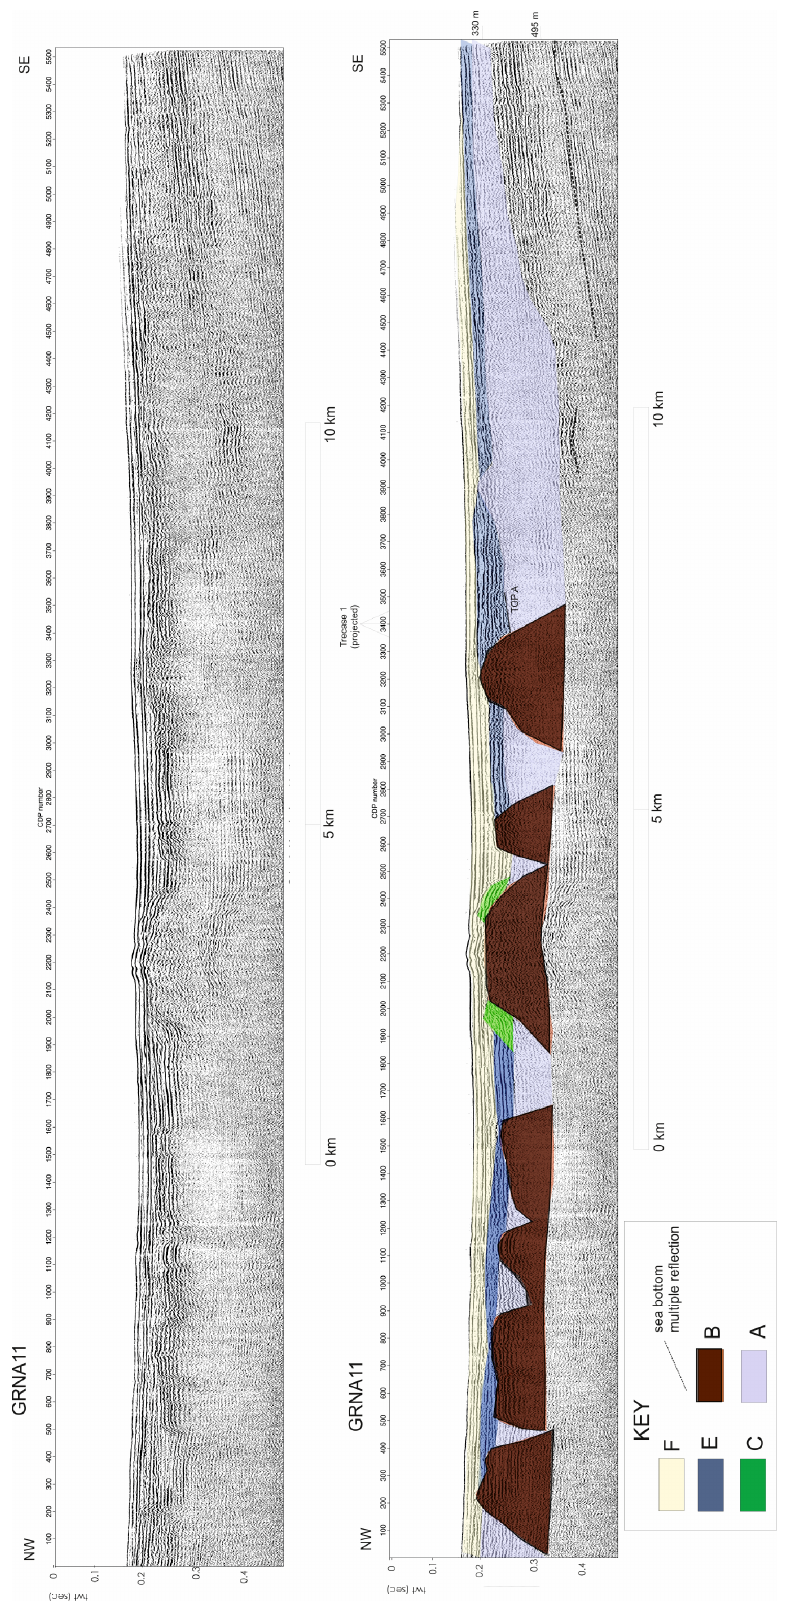
Figure 7. Seismic profile Grna11 and corresponding geologic interpretation, calibrated with the “Trecase 1” well; (Figure 2).